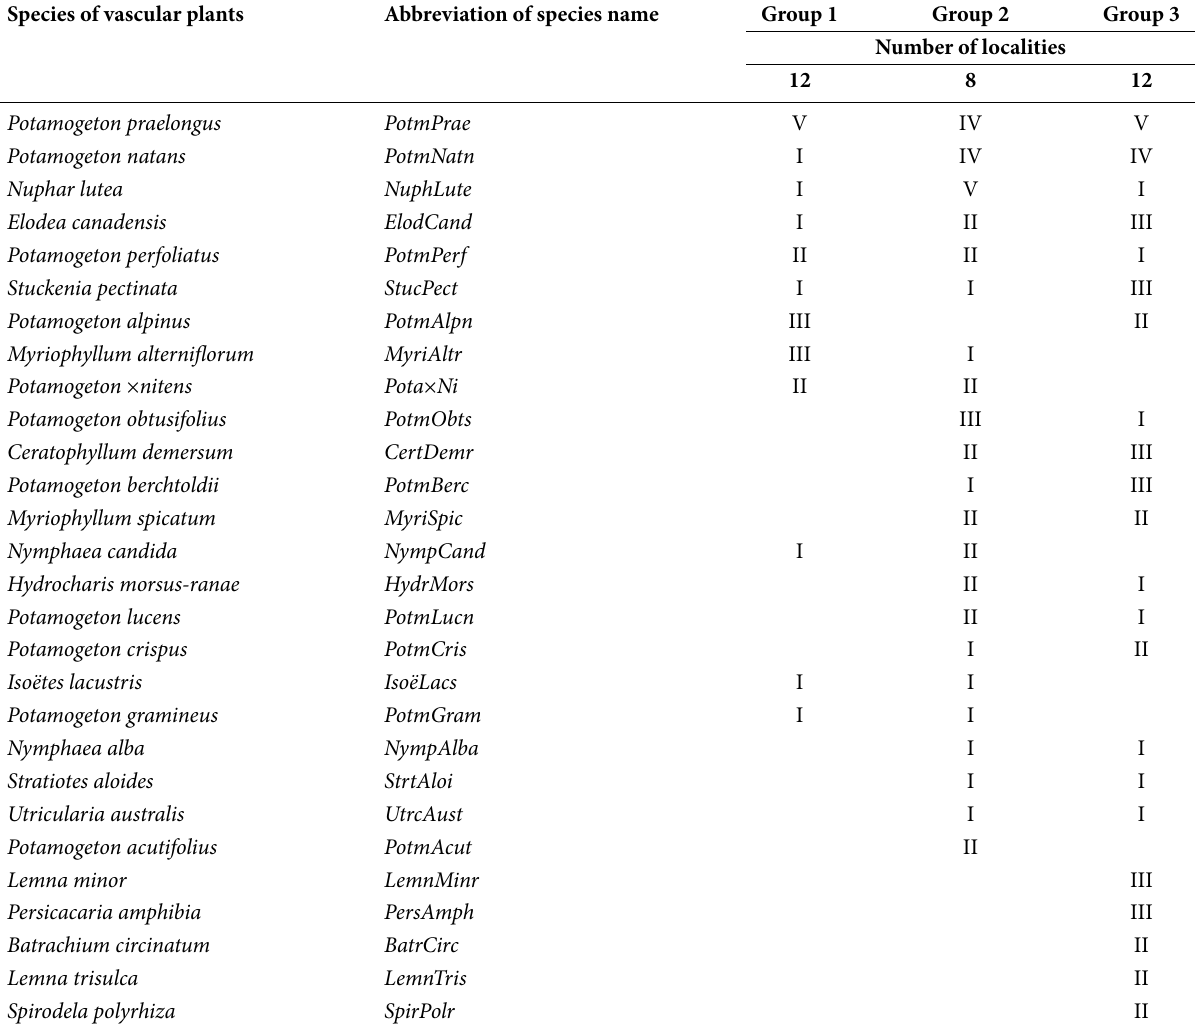
Table 1 Synoptic table of the most frequent species of aquatic plants in three groups of localities (see Table 3). Species of vascular plants